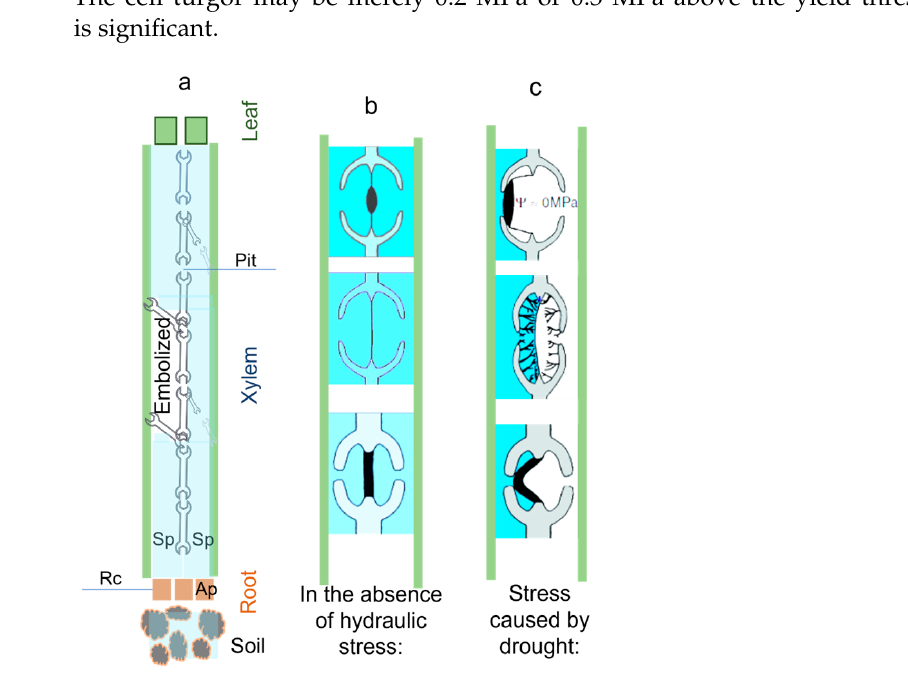
Figure 5. A mechanism for regulating embolisms in the xylem. ( a ) embolism ( b ) without hydraulic stress ( c ) draught-induced stress. stress ( c ) draught-induced